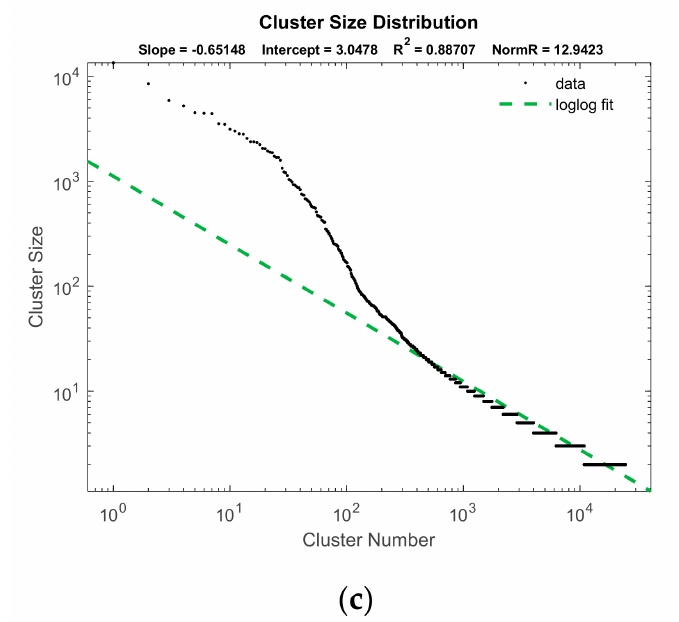
Figure 9. The power-law (log-log) correlation scatterplots for distribution of cluster sizes ( a ), degree ( b ), and betweenness ( c ) values across all datasets. Each graph has details for the goodness of fit stated in R 2 and the norm of residuals. The best fitting one is one representing degree centrality values ( b ) while other graphs have fluctuations. ( a ) has disproportionally larger clusters than most, while ( c ) has nodes with significantly higher and lower betweenness